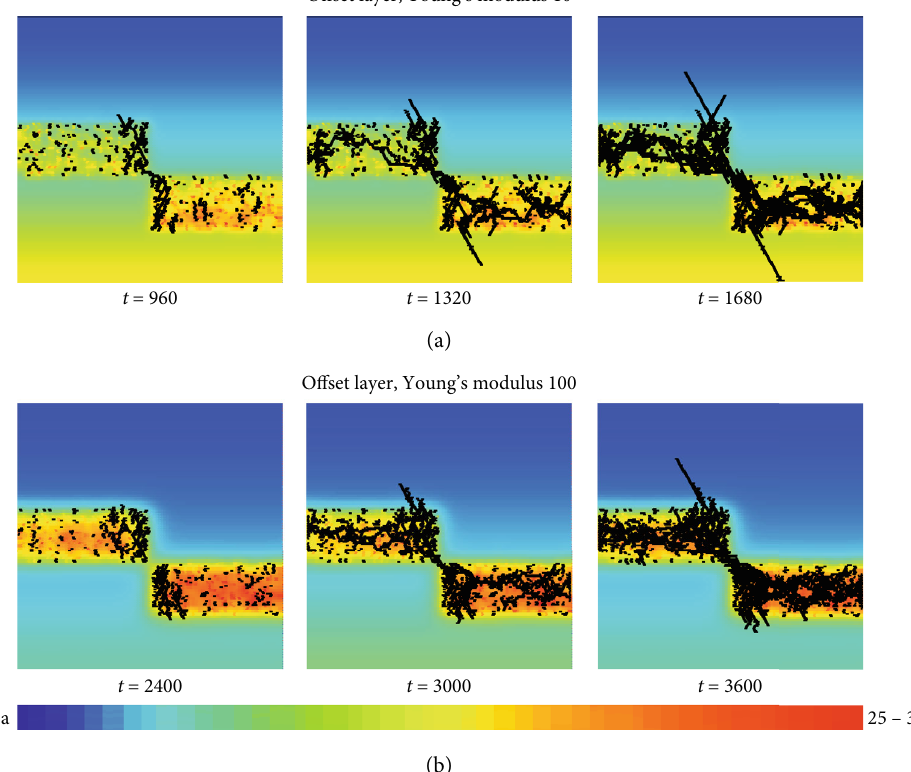
Figure 7: Fracture evolution (in black, with fl uid pressure color coded in the backgrounds) of two faulted layers with di ff erent Young ’ s moduli. (a) Soft layer with Young ’ s modulus of 10GPa and (b) hard layer with Young ’ s modulus of 100GPa. Both hard and soft layers show a similar fracture evolution with the fi rst fractures developing at the end of the layers next to the fault followed by a brecciation of the layer itself. The fracture density is slightly higher in the hard layer with the main di ff erence being the timing of fracturing, which is signi fi cantly earlier in the soft